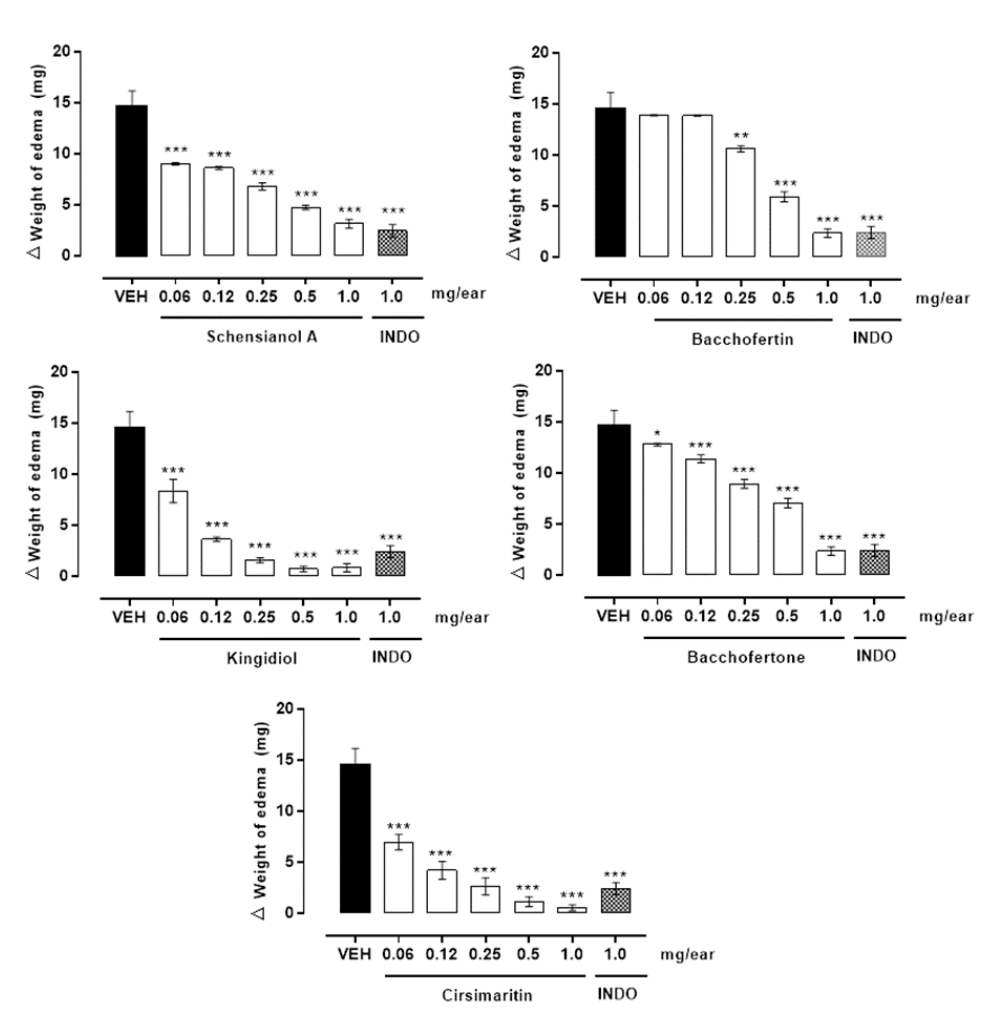
Figure 4. Curve dose-response of isolated compounds from B. conferta on TPA-induced ear edema. Each treatment with TPA (VEH) immediately before the application of schensianol A ( 1 ), bacchofertin ( 2 ), kingidiol ( 3 ), bacchofertone ( 5 ), hispidulin ( 6 ) and cirsimaritin ( 7 ). The bars show the mean ± S.E.M. of the weight di ff erence in milligrams (mg) (n = 5) 6 h after TPA application. Significantly di ff erent from VEH, * p < 0.05, ** p < 0.01, *** p < 0.0001. 183 Table 4. Anti-inflammatory activity compounds from B. conferta . 184 Compounds E max ED 50 (mg/ear)